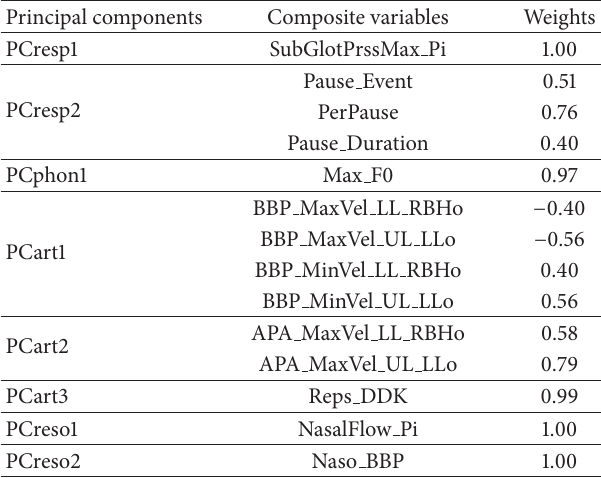
Table 1: The key variables and the corresponding weights that comprise the principal components of each speech subsystem. The composite variables are spelt out